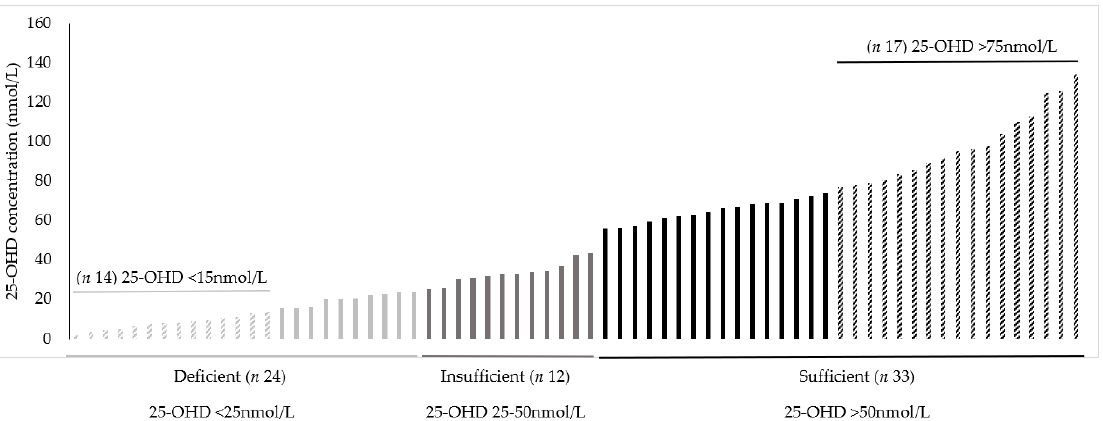
Figure 2. Plasma 25-OHD concentration (nmol/L) of ( n 69) participants within deficient, insufficient and sufficient vitamin D status categories.